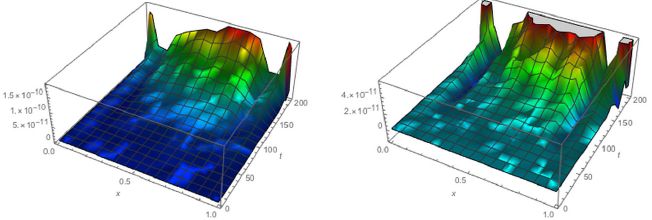
Figure 4. The absolute errors for γ = 0 . 25 (left) and γ = 0 . 5 (right) with M = 10 ,N = 3 and β = 1 on the interval [0 , 1] × [0 , 200] of Example 5.